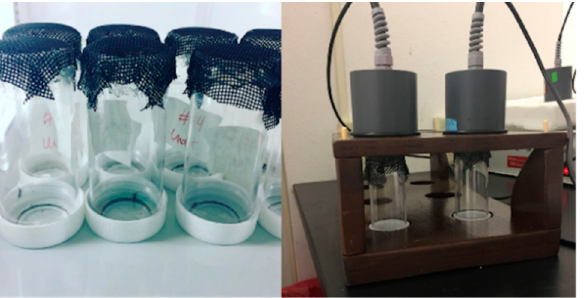
Figure 1. Experimental setup. Individual mosquitoes were housed in plastic canisters covered with fiberglass screen ( left ) and offered blood using the Hemotek artificial feeding system with the 300 μ L reservoir and a custom stand ( right